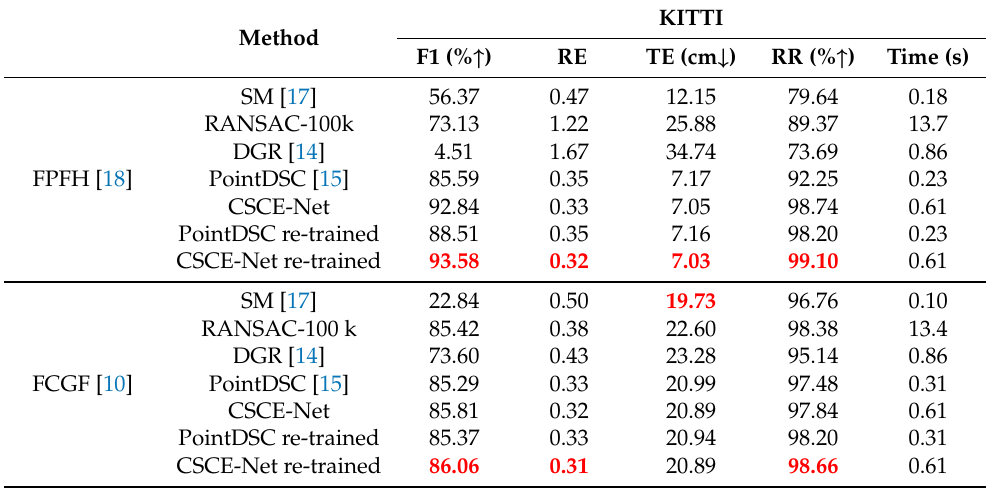
Table 3. Quantitative results of outlier rejection and pose estimation on the KITTI datasets.